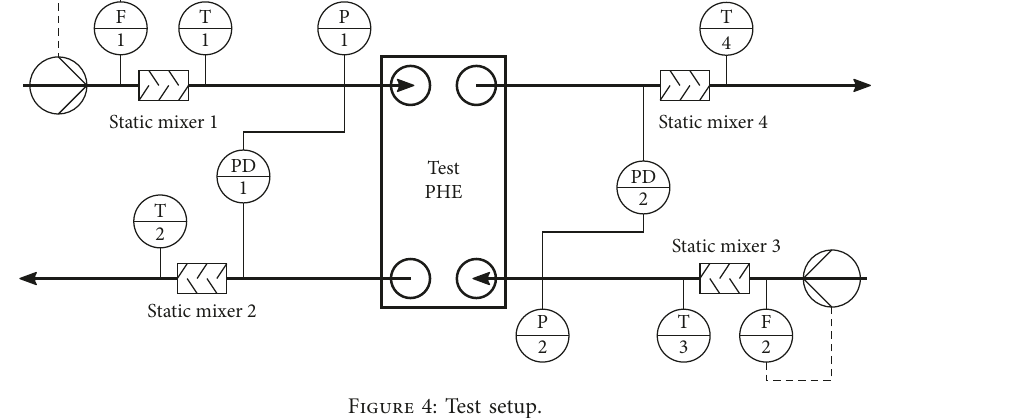
Figure 4: Test setup.